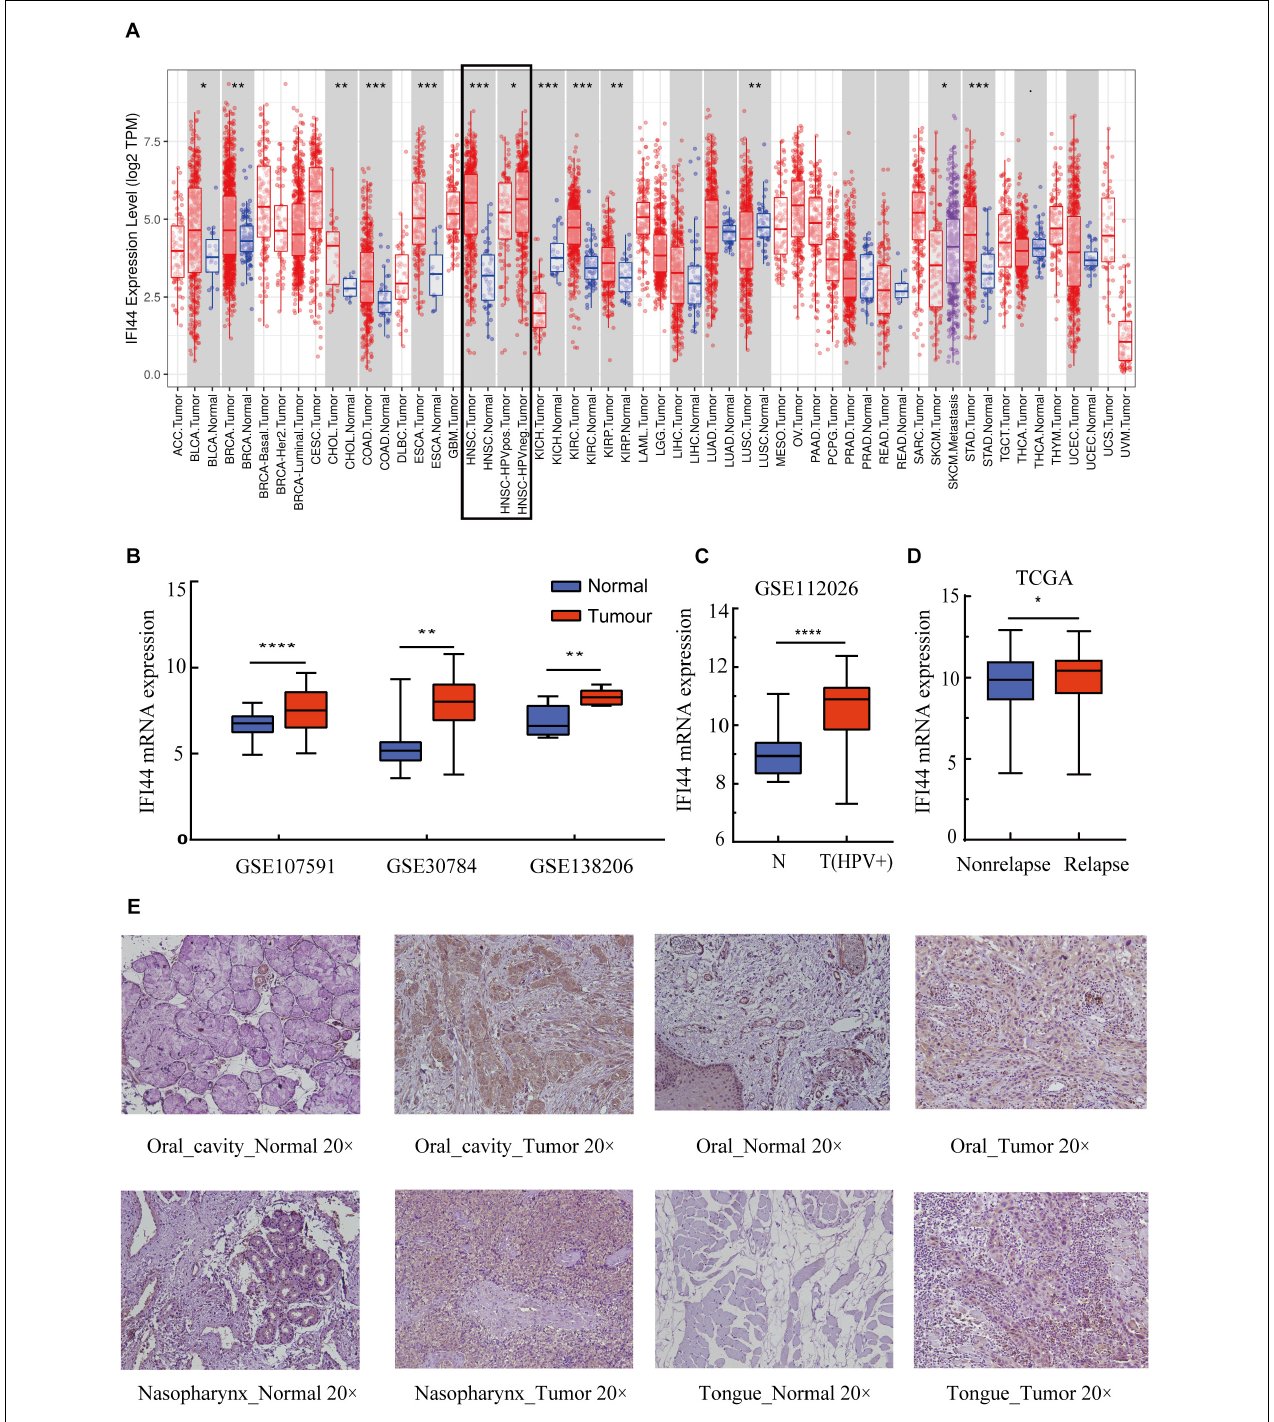
FIGURE 1 | The different IFI44 expression in multiple cancers. (A) The different IFI44 expression in TCGA Pan-cancer samples including tumor and normal tissues analyzed by TIMER database. (B) The overexpression of IFI44 in head and neck squamous cell carcinoma (HNSC) tumor section was confirmed in three GEO datasets (GSE107591, 45 normal vs. 167 cancer, P < 0.0001; GSE30784, 23 normal vs. 24 cancer, P = 0.0076; GSE138206, 12 normal vs. 6 cancer, P = 0.0023). (C) Human papillomavirus (HPV)-positive oral cavity carcinoma (OCC) expressed higher IFI44 than normal samples (GSE112026, 25 normal vs. 47 cancer, P < 0.0001). (D) IFI44 was highly expressed in HNSC relapsed samples than non-relapsed patients (non-relapsed, n = 351; relapsed, n = 133, P = 0.0315). (E) Expression of IFI44 proteins in different tumor tissues and paired normal tissues in HNSC by immunohistochemistry assay. (P-value significant codes: * P < 0.05; ** P < 0.01; *** P < 0.001; **** P < 0.0001).